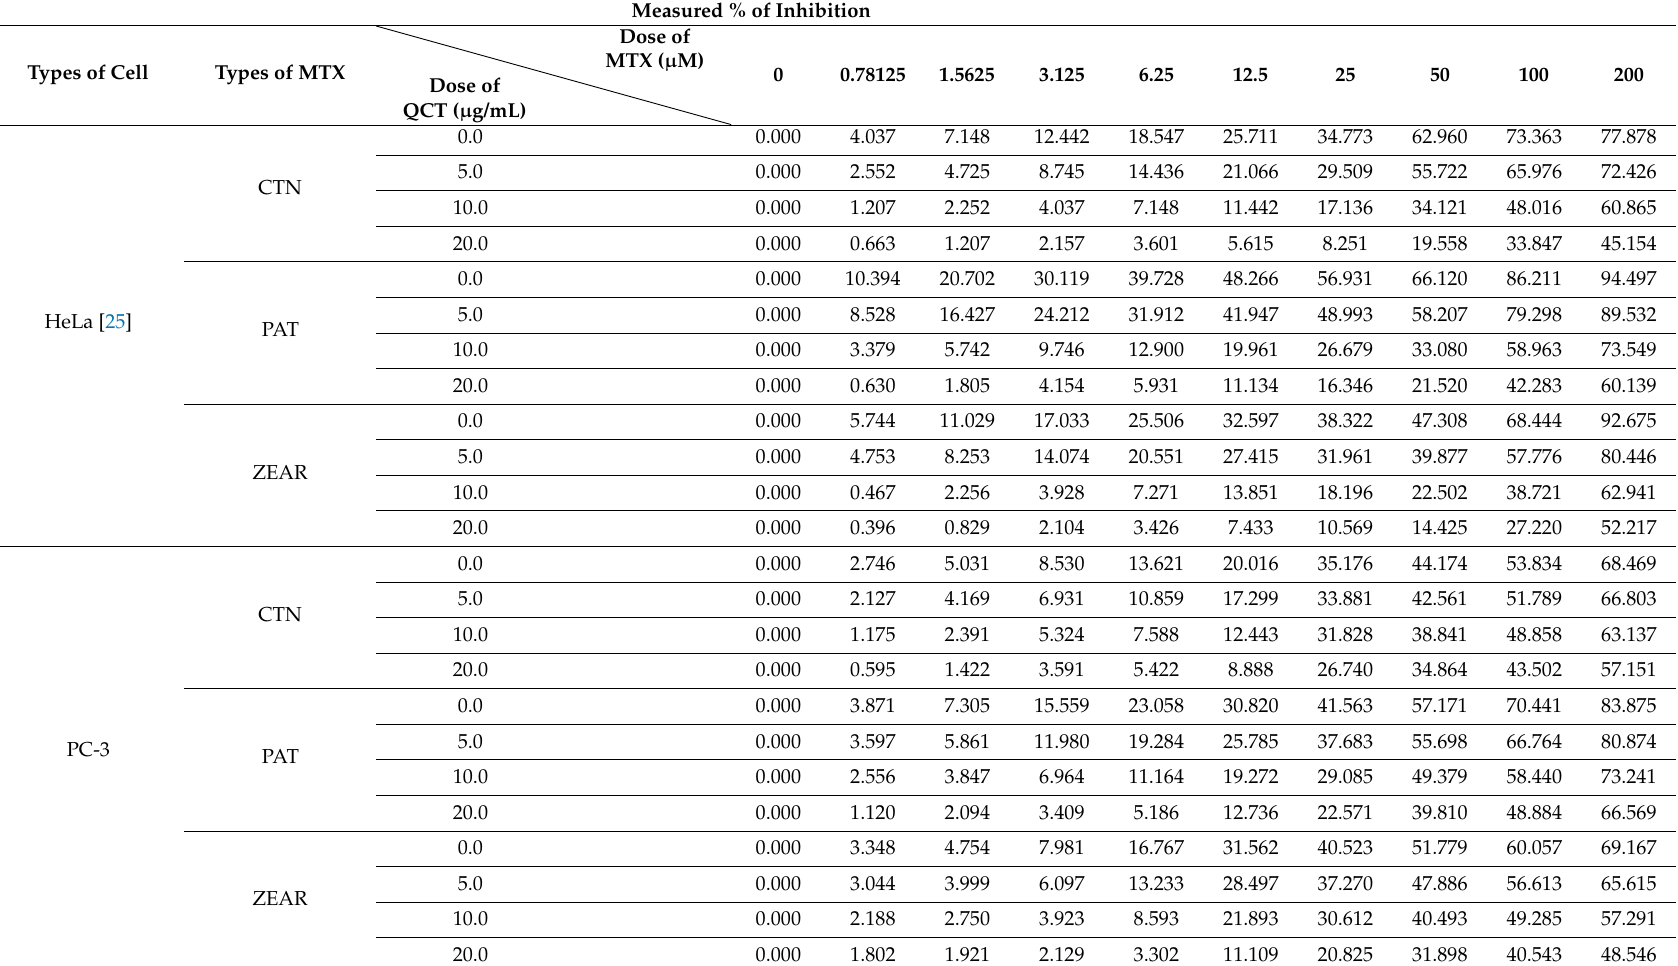
Table 1. Measured % of inhibition for neural network